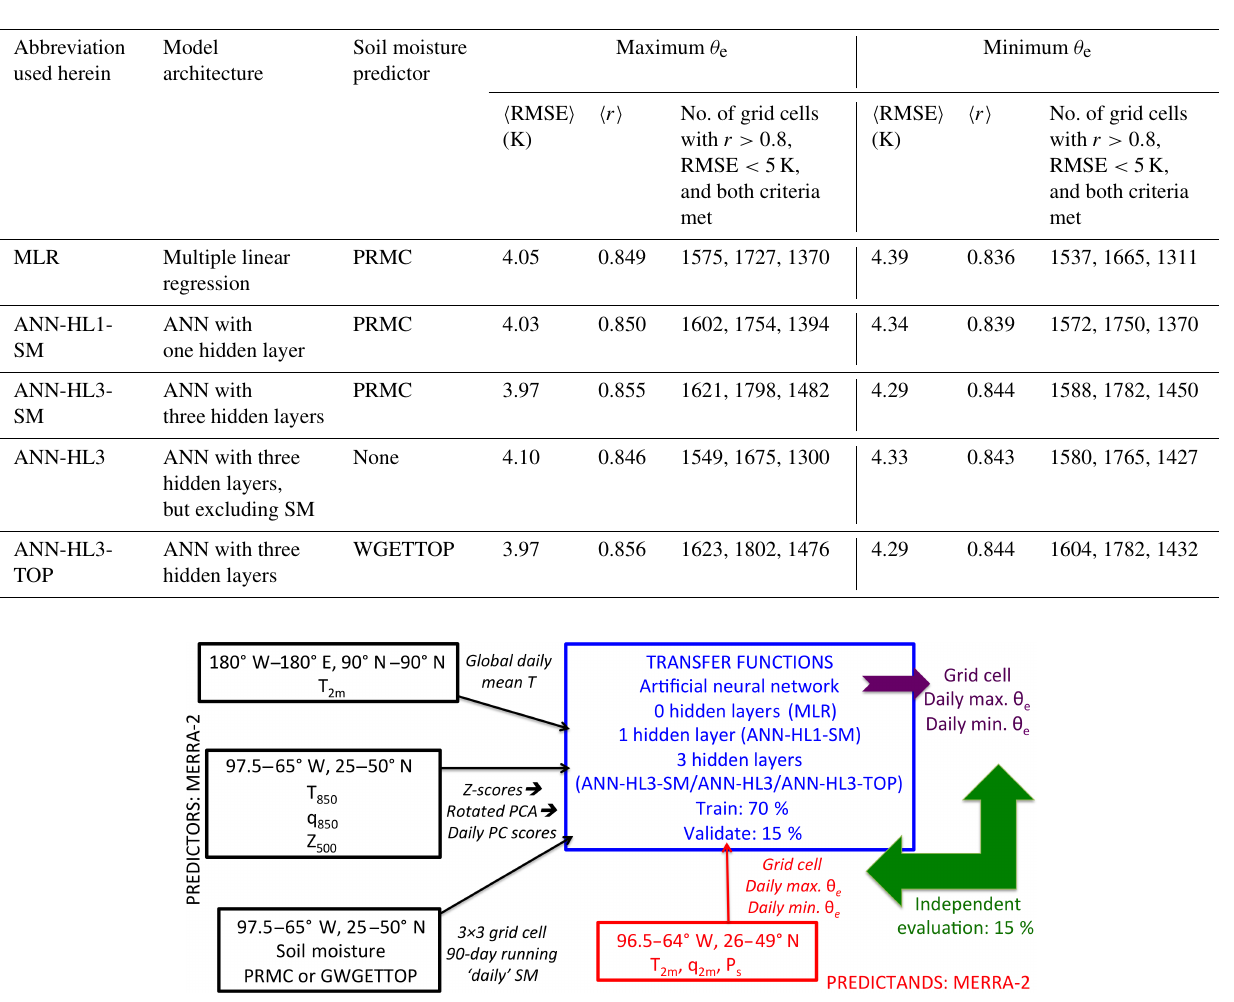
Table 1. Domain-averaged model performance statistics (root mean square error (RMSE) and the mean Pearson correlation coefficient r ) vs. independent test data for daily maximum equivalent potential temperature (maximum θ e ) and daily minimum equivalent potential temperature (minimum θ e ) during JJA, 1980–2015. The results are shown for the five model formulations expressed in terms of the number of hidden layers in the ANN (where 0 hidden layers indicates results for a multiple linear regression model with no term interactions), the presence or absence of soil moisture as a predictor, and whether the SM is total columnar (PRMC) or surface only (WGETTOP). The total number of grid cells considered herein is 1960.